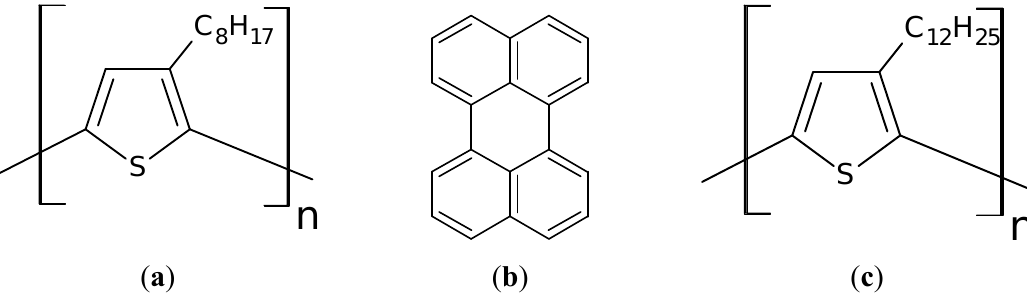
Figure 7. Molecular structures of ( a ) P3OT; ( b ) perylene and ( c )